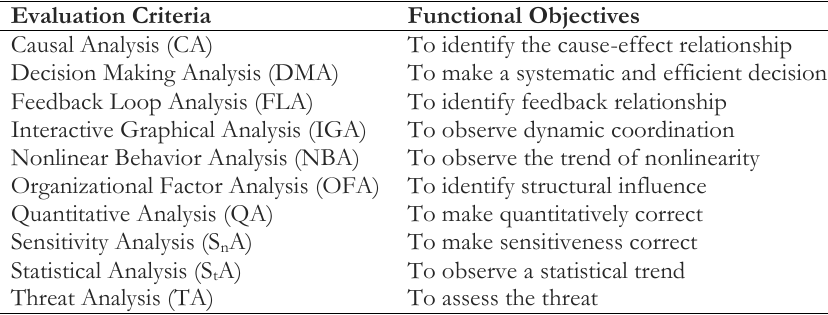
Table 1. Identified evaluation criteria with functional